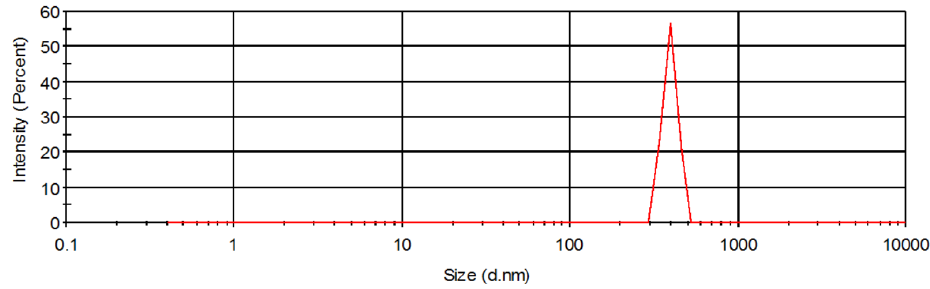
Figure 1. Particle size distribution of C/SiO 2 composite.